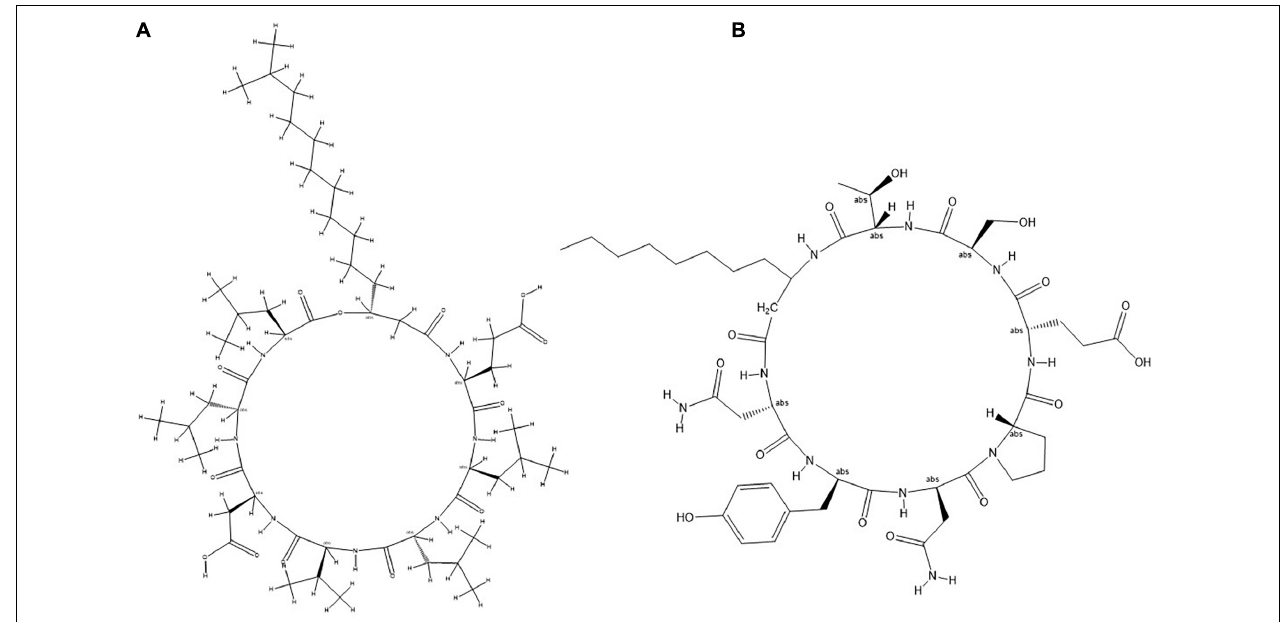
FIGURE 8 | General molecular structure of lipopeptides (A) Surfactin and (B) Bacillomycin isolated from B. siamensis strain NKIT9. TABLE 3 | Effects of strain NKIT9 on seedling germination, the suppression of damping-off of tomato plants caused by R. solani 15 days after planting * . Treatments Seedling germination (%) Diseased plants % 74.44 ±